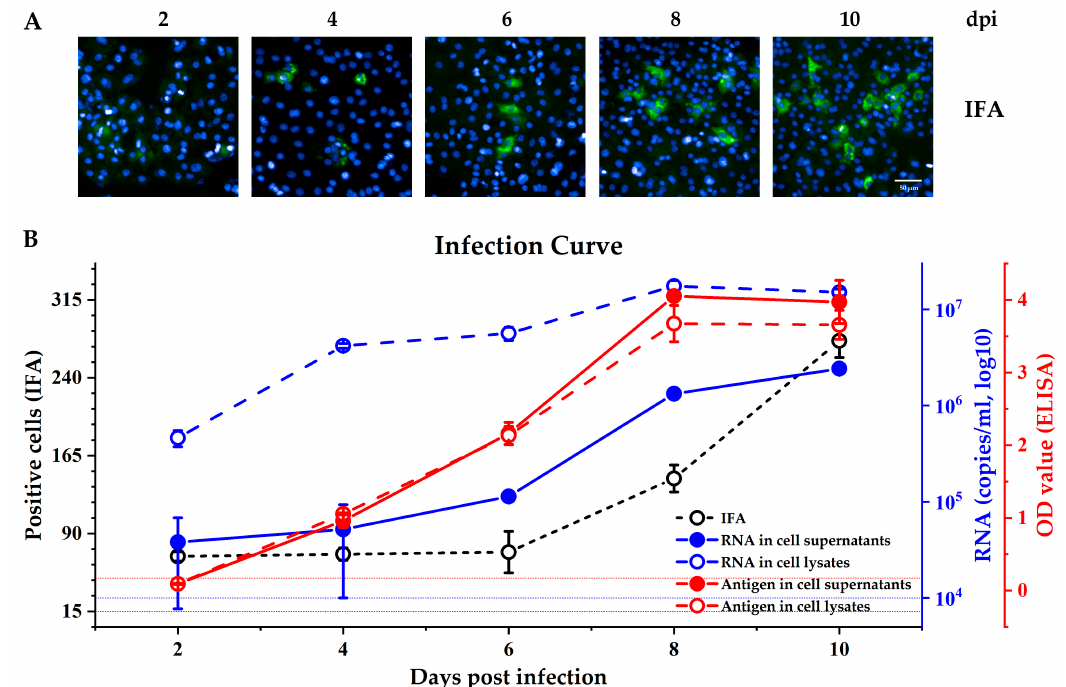
Figure 1. Hepatitis E virus (HEV) infection kinetics in HepG2/C3A cells. ( A ) Immunofluorescence images show the expression of pORF2 (green) at different times after inoculation. The scale bar represents 50 µ m. ( B ) The number of positive cells determined by immunofluorescence focus assay (IFA) is shown as a black line. The black dashed line represents average positive cells in the negative controls. HEV antigen pORF2 in the supernatant and cell lysate was detected by an HEV antigen test (red lines). The red dashed line (OD value = 0.17) represents the cut-off value of the negative controls. HEV RNA in the supernatants and cell lysates of HEV-infected HepG2 culture (blue lines). The blue short dashed line indicates the qRT-PCR detection limit. The results represent the means ± SEMs of four independent experiments.